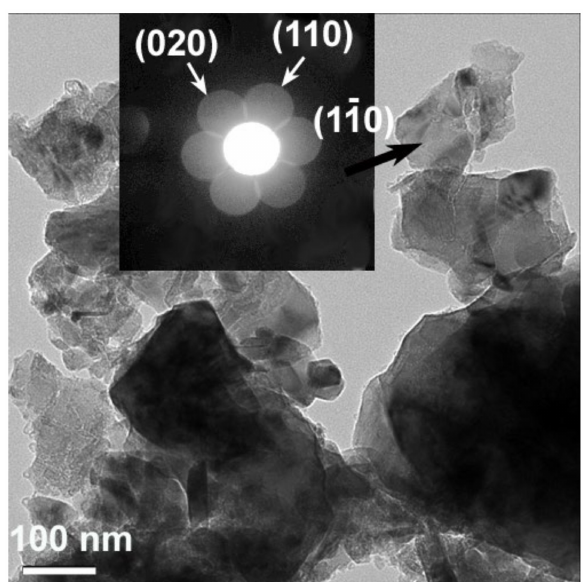
Figure 1. Bright field TEM image of the particles of pristine Li 2 MnO 3 material. The insert shows an example of CBED pattern, which was taken from the particle indicated by an arrow. The pattern was indexed on the basis of the monoclinic Li 2 MnO 3